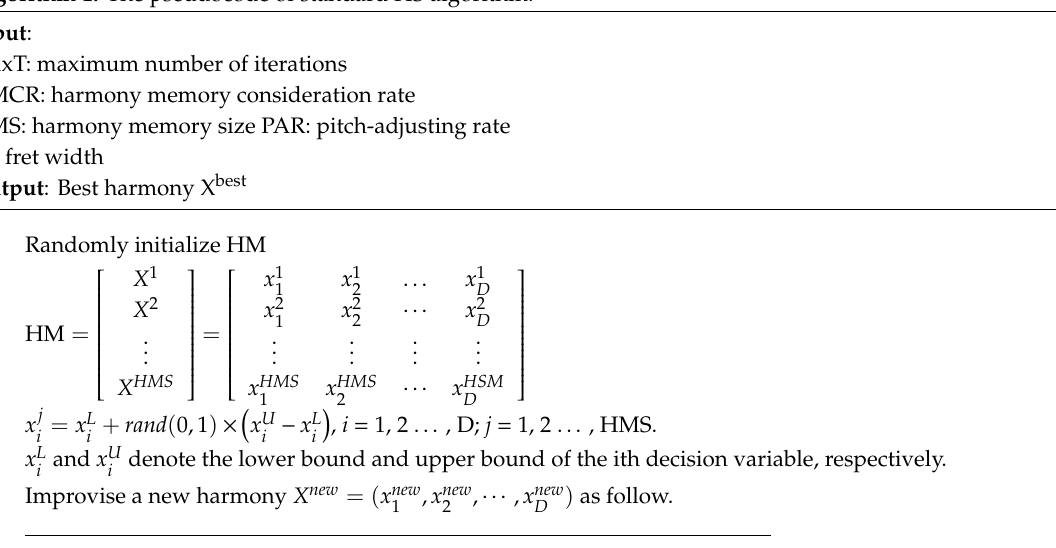
Algorithm 1. The pseudocode of standard HS